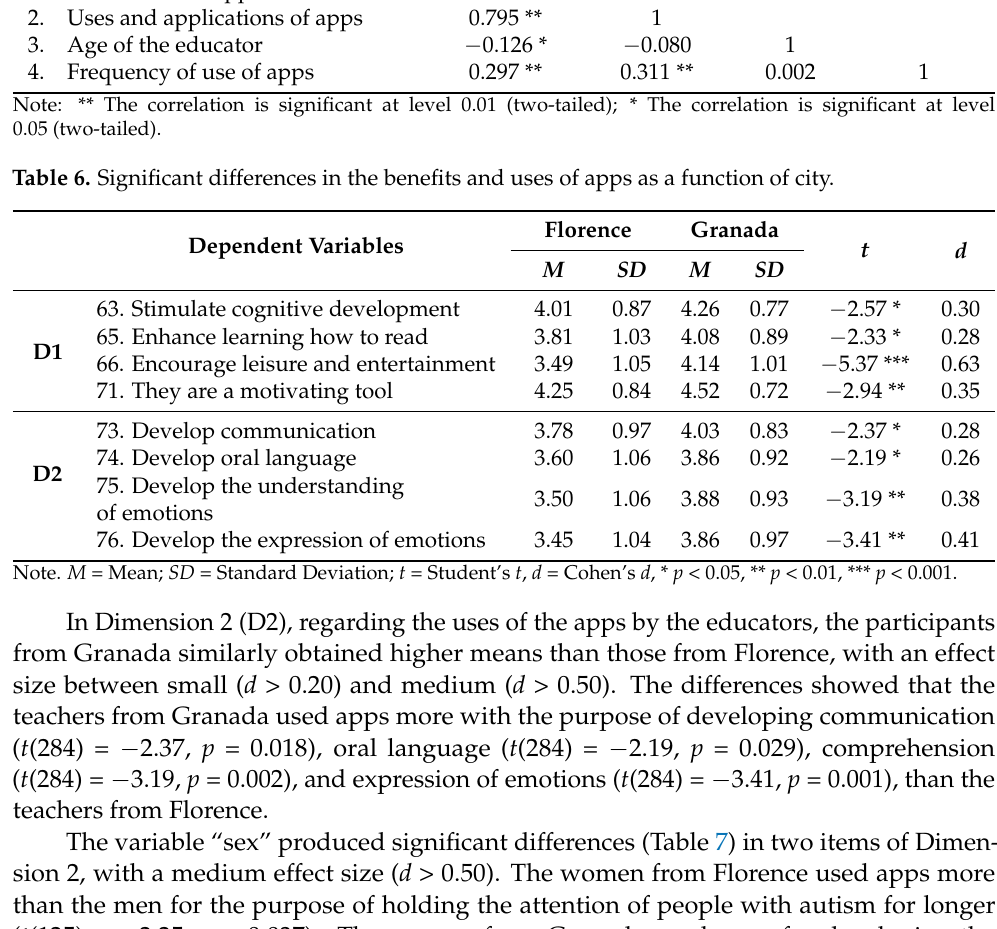
Table 5. Pearson’s correlation coefficient between the benefits of the apps, the uses and applications, the age of the educator, and the frequency of use. Benefits Uses Age